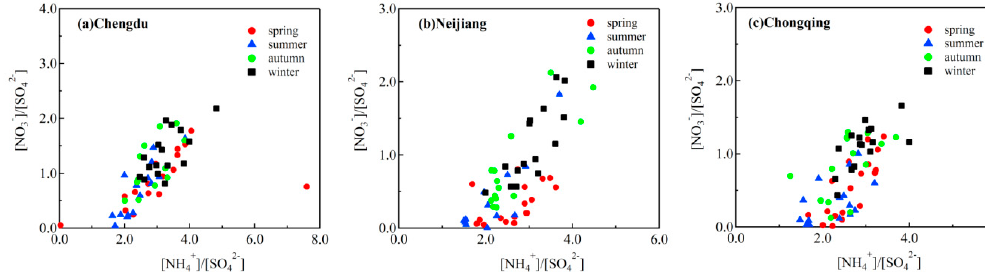
Atmosphere 2019 , 10 , x FOR PEER REVIEW 10 of 13 promote N 2 O 5 uptake on the aerosol surfaces. On the other hand, the high concentrations of PM 2.5 Figure 5. [NO 3 − ]/[SO 42 − ] ratio as a function of [NH 4+ ]/[SO 42 − ] in ( a ) CD, ( b ) NJ, and ( c ) CQ. mass and large fractions of WSIIs with acidic conditions would favor the hydrolysis of N 2 O 5 [34].